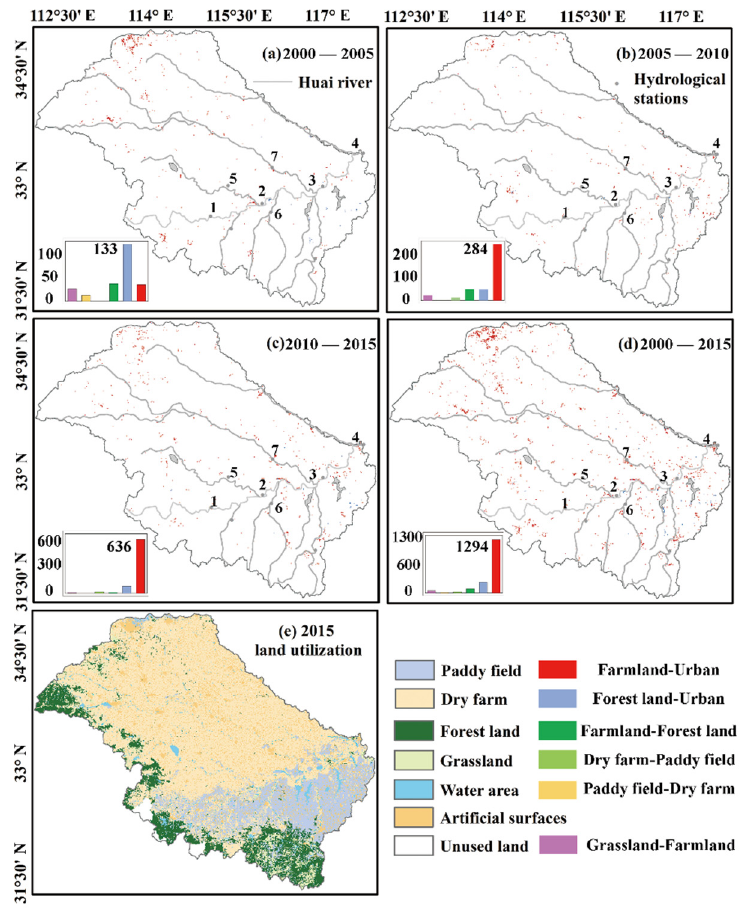
Figure 16. Spatial transformation variation map of land-use type of the HRB.